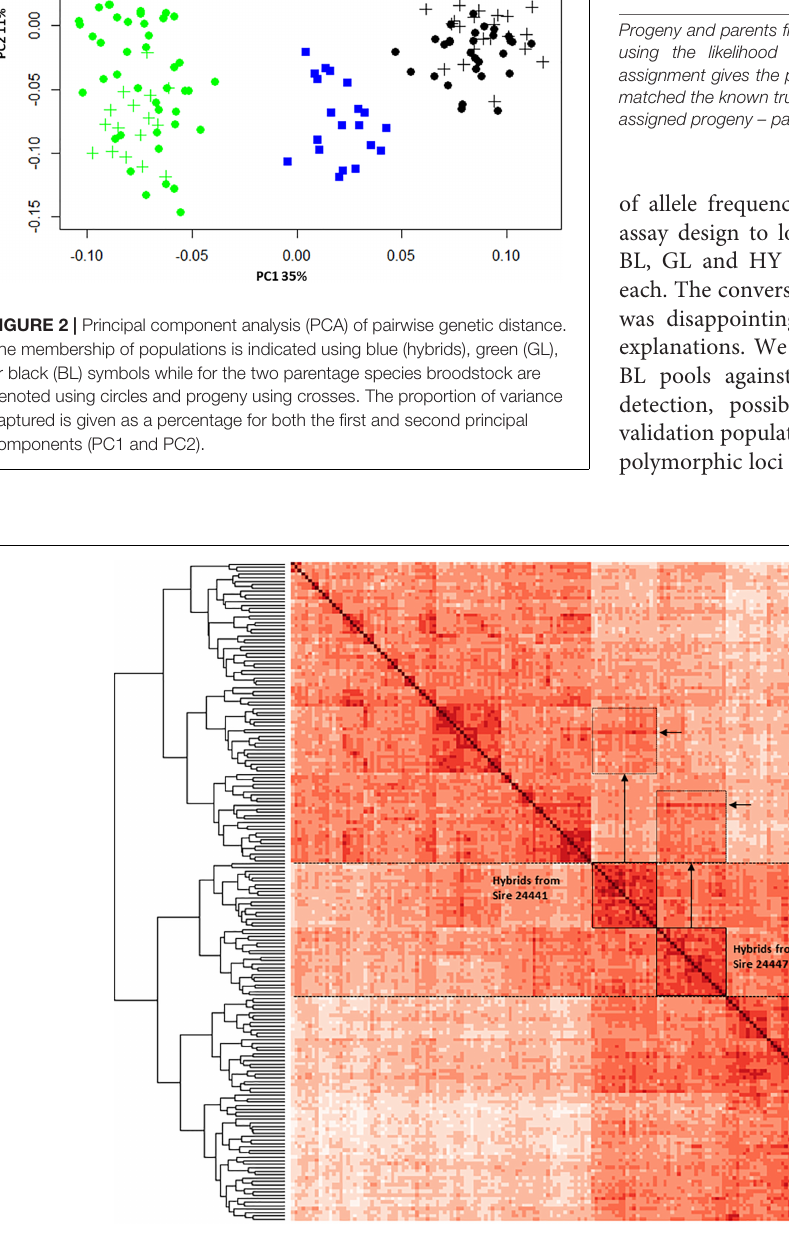
FIGURE 3 | Relationship of 191 abalone from three populations. Pairwise allele sharing ( A S ) was used to construct a dendogram (at left) and heatmap. Cell color represents the strength of allele sharing, where increasingly dark shades indicate increasing relatedness between animals. Self-self comparisons appear on the diagonal with maximum A S = 1 and darkest color. Hybrids branch as intermediate between the two parentage species, and consist of two groups which are indicated using boxes. Vertical arrows connect off diagonal regions of the heatmap with elevated A S (hatched boxes). Rows corresponding to the greenlip sires used in the construction of the hybrids (sires 24441 and 24447) are shown with horizontal